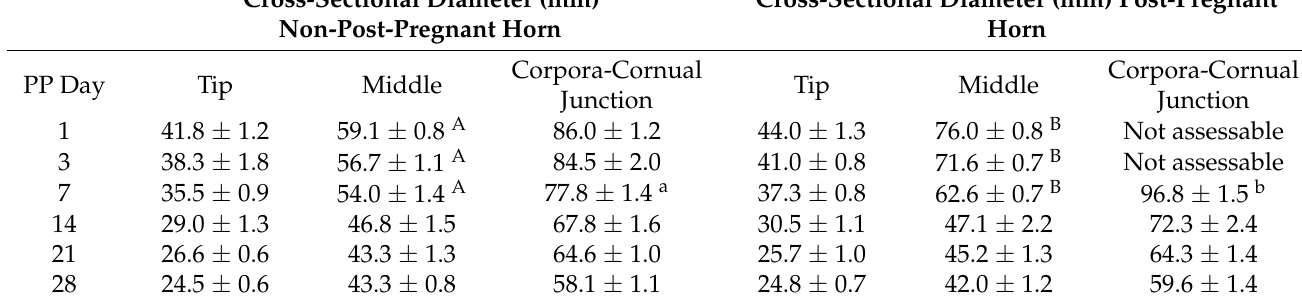
Table 1. Postpartum cross-sectional diameter measured (mean ± SD) at the non-post-pregnant and post-pregnant uterine horns at the level of the tip, middle, and corpora-cornual junction regions, at the different sampling times, in the 9 Martina Franca